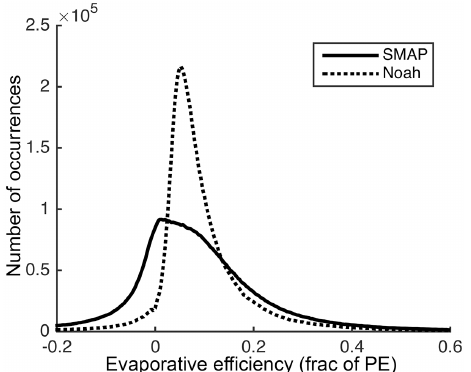
Figure 5. Histograms (200 bins) of evaporative efficiencies ob- served by SMAP and simulated by Noah.